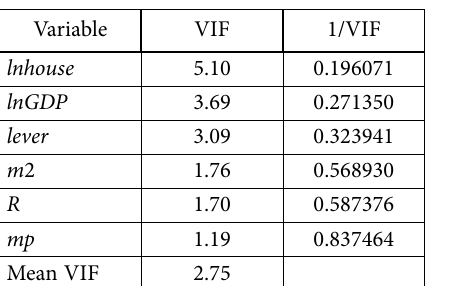
Table 2. Variance inflation factor test Table 3. Panel HT unit root